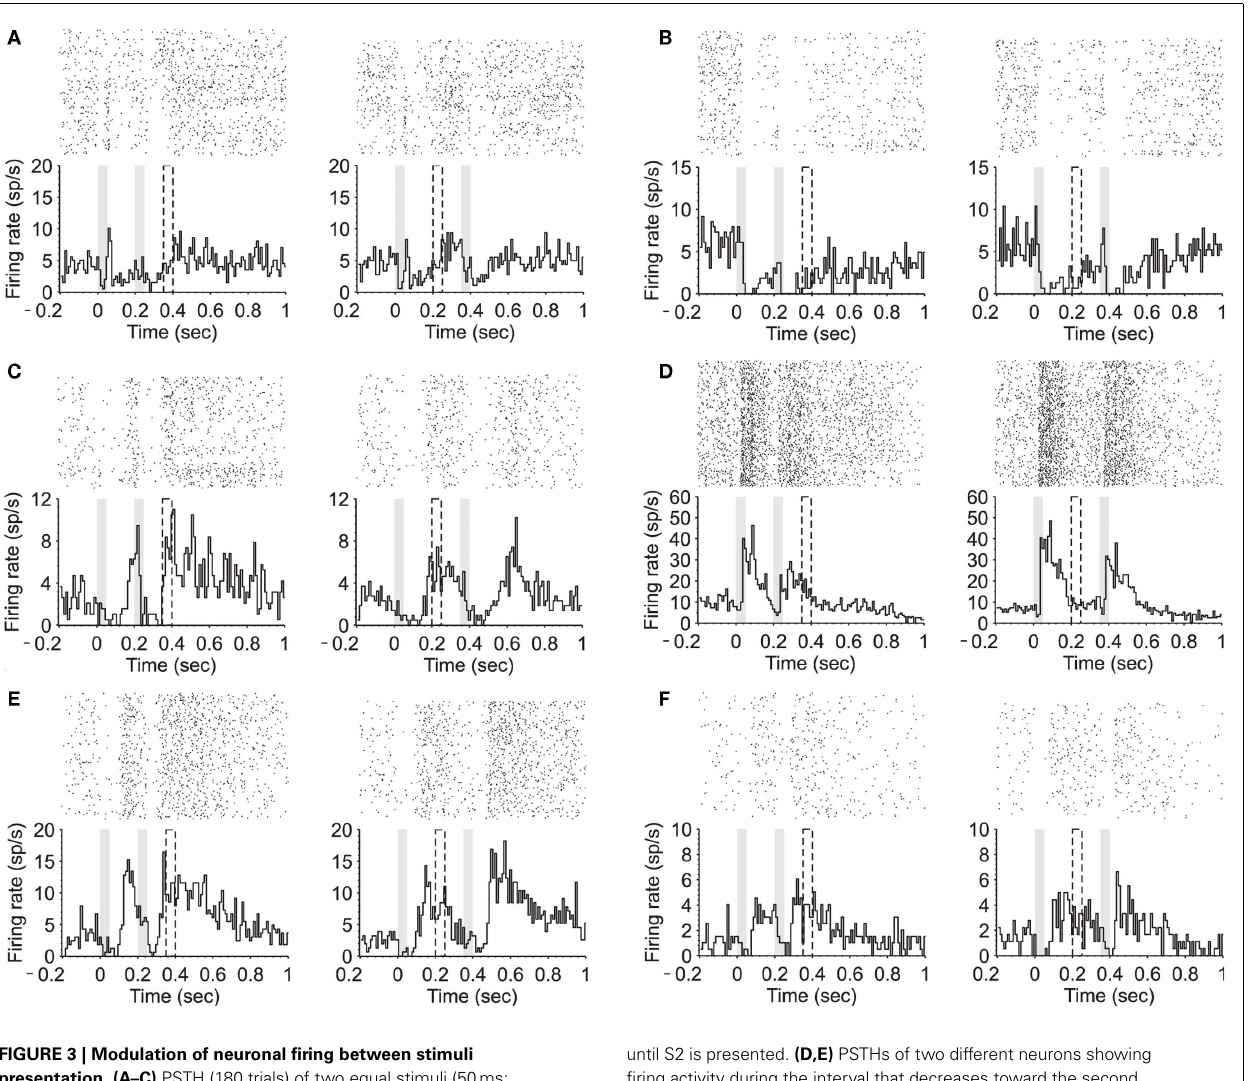
FIGURE 3 | Modulation of neuronal firing between stimuli presentation. (A–C) PSTH (180 trials) of two equal stimuli (50ms; 80dB; 5322Hz) separated by either 150ms (left) or 300ms (right). Three example neurons during the attentive task show suppressive activity during stimuli presentation followed by an increased firing